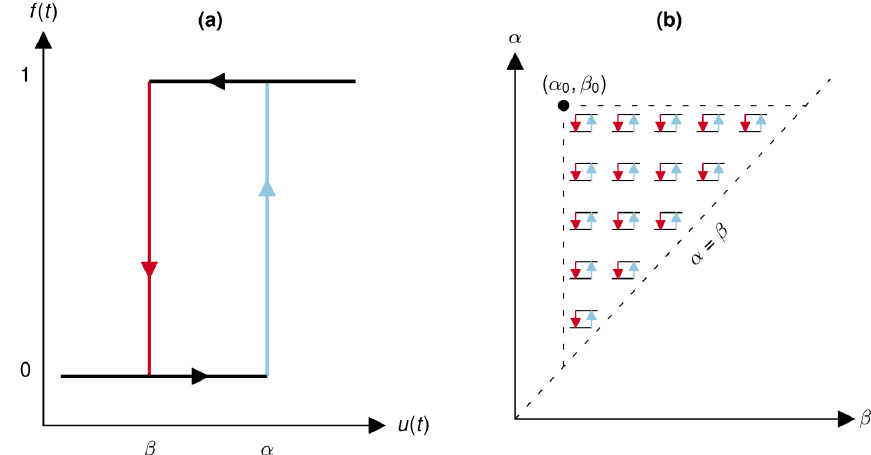
Figure 1. (a) The hysteron forms the foundation of the Preisach model, making output ( f ) dependent on threshold input values ( α , β ) and the previous output value. (b) The study of hysteresis on the system level is enabled by considering an infinitude of hysterons spread over a limiting triangle, in which each coordinate pair corresponds to specific threshold values ( α i , β i